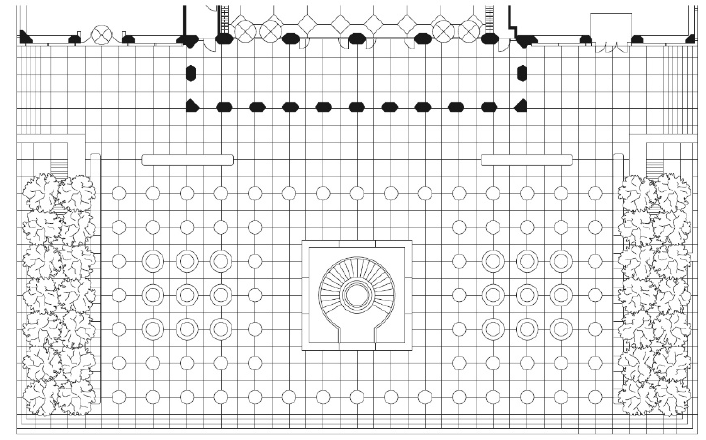
Figure 5. GlassentrancepaviliontotheAppleRetailStore,FifthAvenueinNewYork (© Foster + Figure 5. Glass entrance pavilion to the Apple Retail Store, Fifth Avenue in New York (© Foster + Partners).